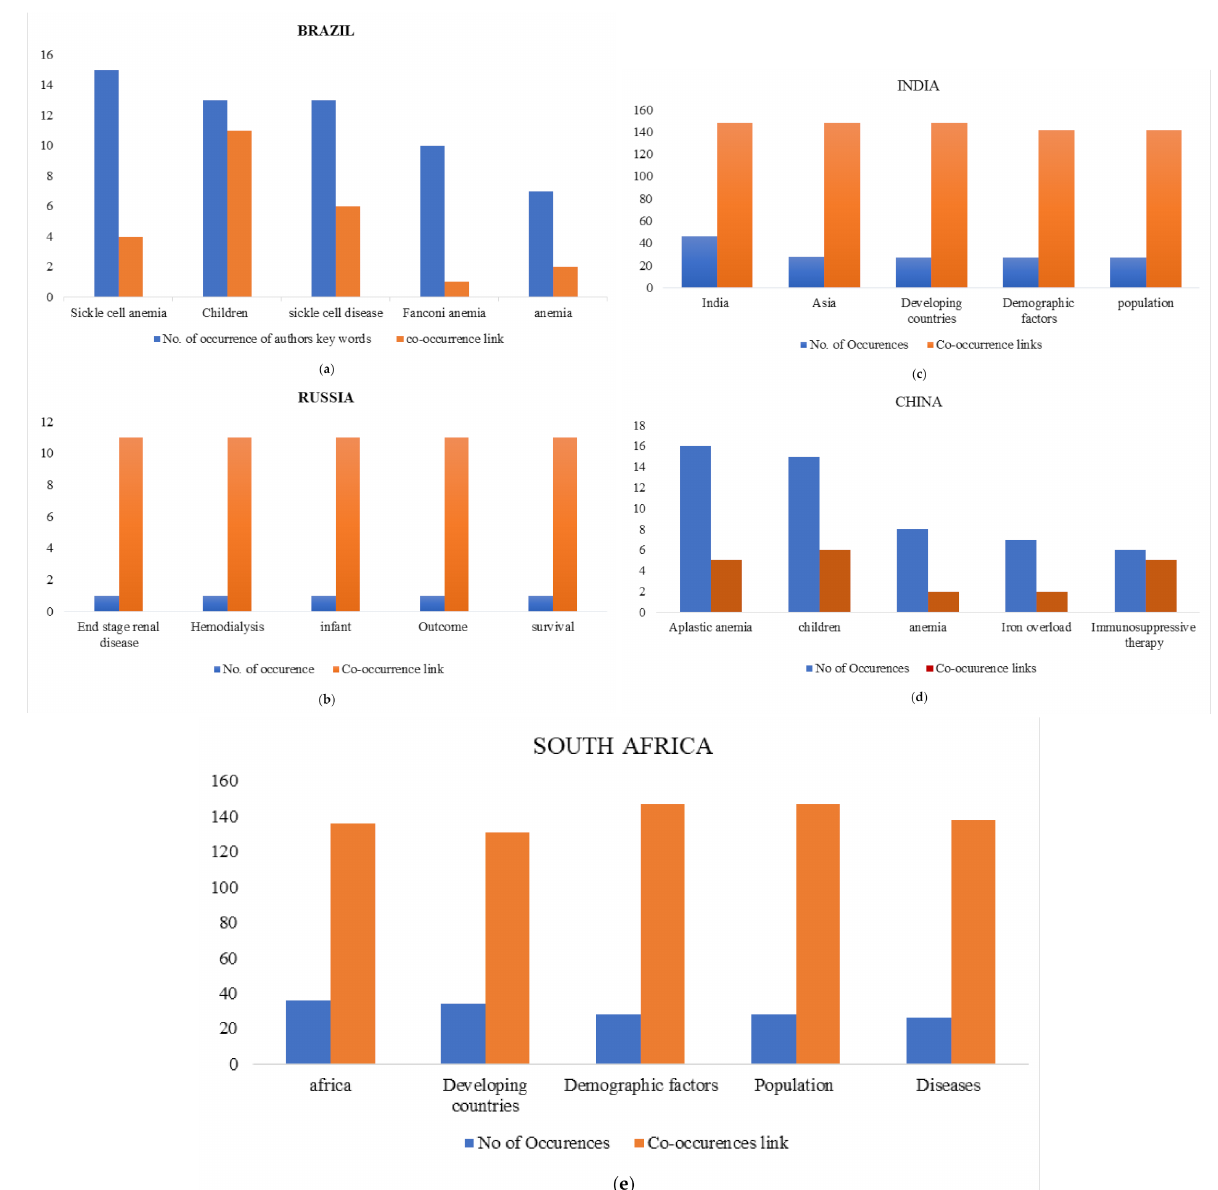
Figure 5. ( a ) Top author keyword analysis: Brazil. ( b ) Top author keyword analysis: Russia. ( c ) Top author keyword